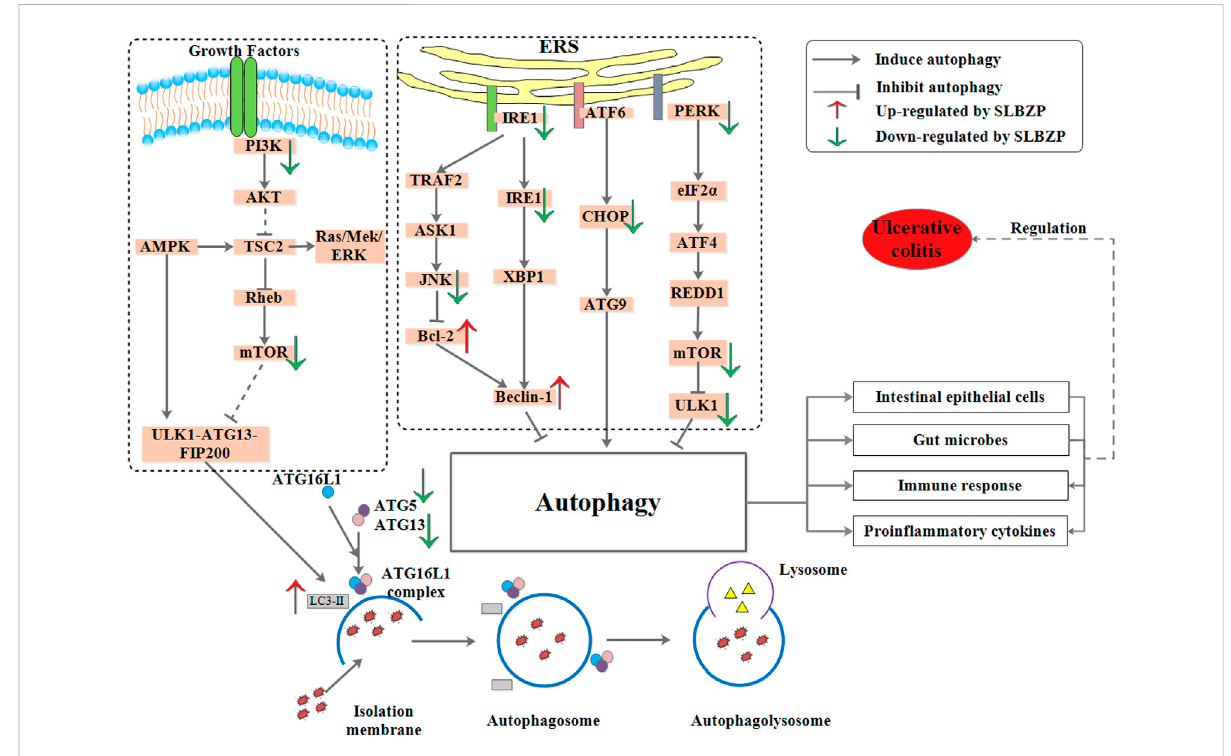
FIGURE 5 Autophagy and endoplasmic reticulum stress were regulated by